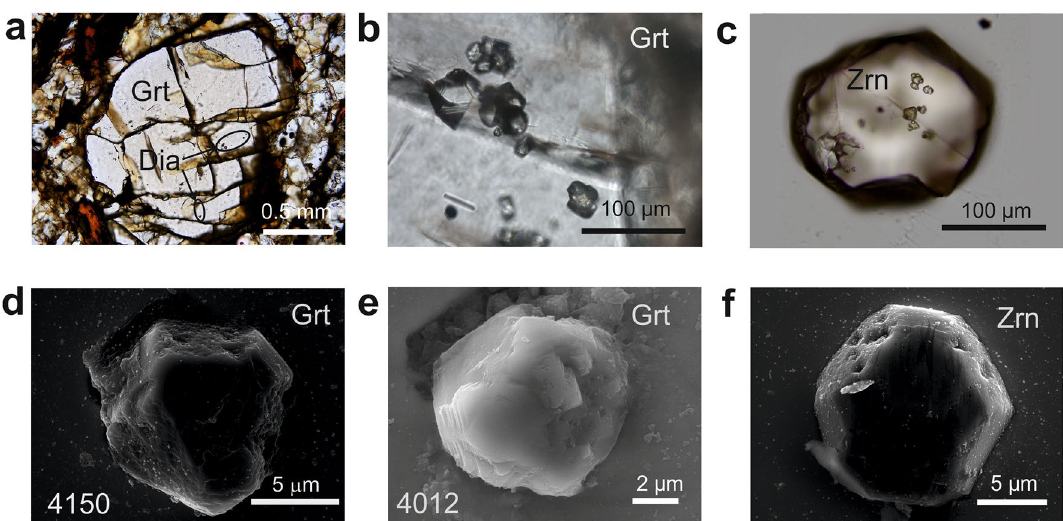
Figure 2. Distribution, mode of occurrence, morphology and surface of microdiamonds, rock B. Photomicrographs showing ( a ) distribution of diamond in the outer core domain of garnet, ( b ) clusters of diamond cubo-octahedra in garnet, and ( c ) distribution of diamond in zircon. ( d – f ) SE images showing common irregular shape and rough surface features ( d , e ) as well as rare regular ( f ) shape of diamonds. Four- digit numbers refer to FIB-TEM sample numbers in Supplementary Table